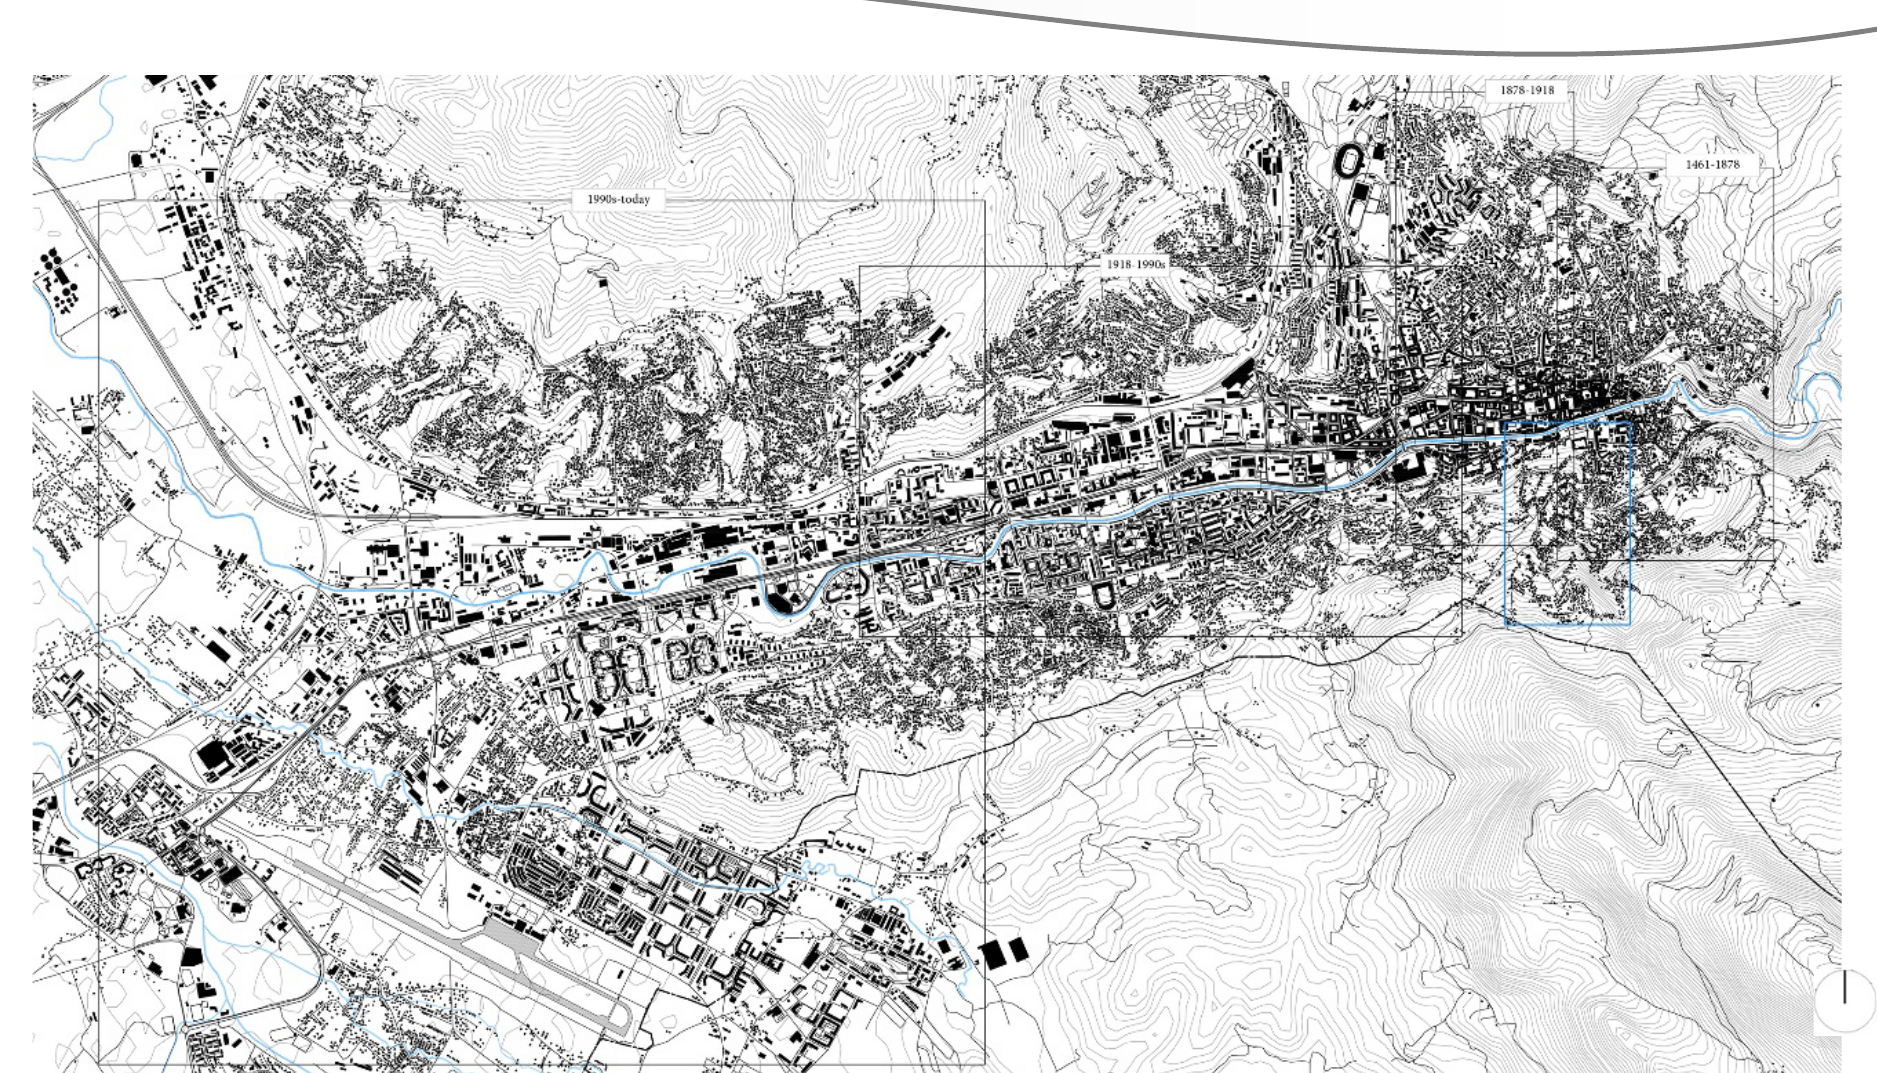
Figure 2: Map of Sarajevo showing the juxtaposed urban stratification resulting from the city’s past and the case-study mahala of Širokača (blue